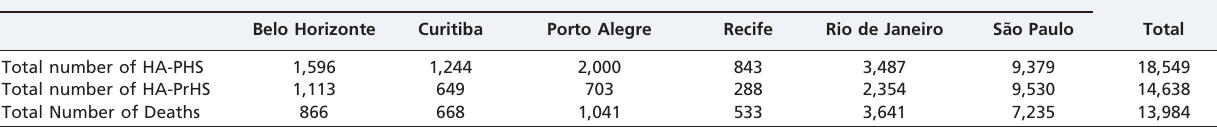
Table 4 - Total Number of Hospital Admissions (HA) due to Respiratory and Cardiovascular diseases in the Public (PHS) and Private Health Systems (PrHS) and Total Number of Deaths in the six Brazilian Metropolitan Areas between 2009 and 2040 attributable to